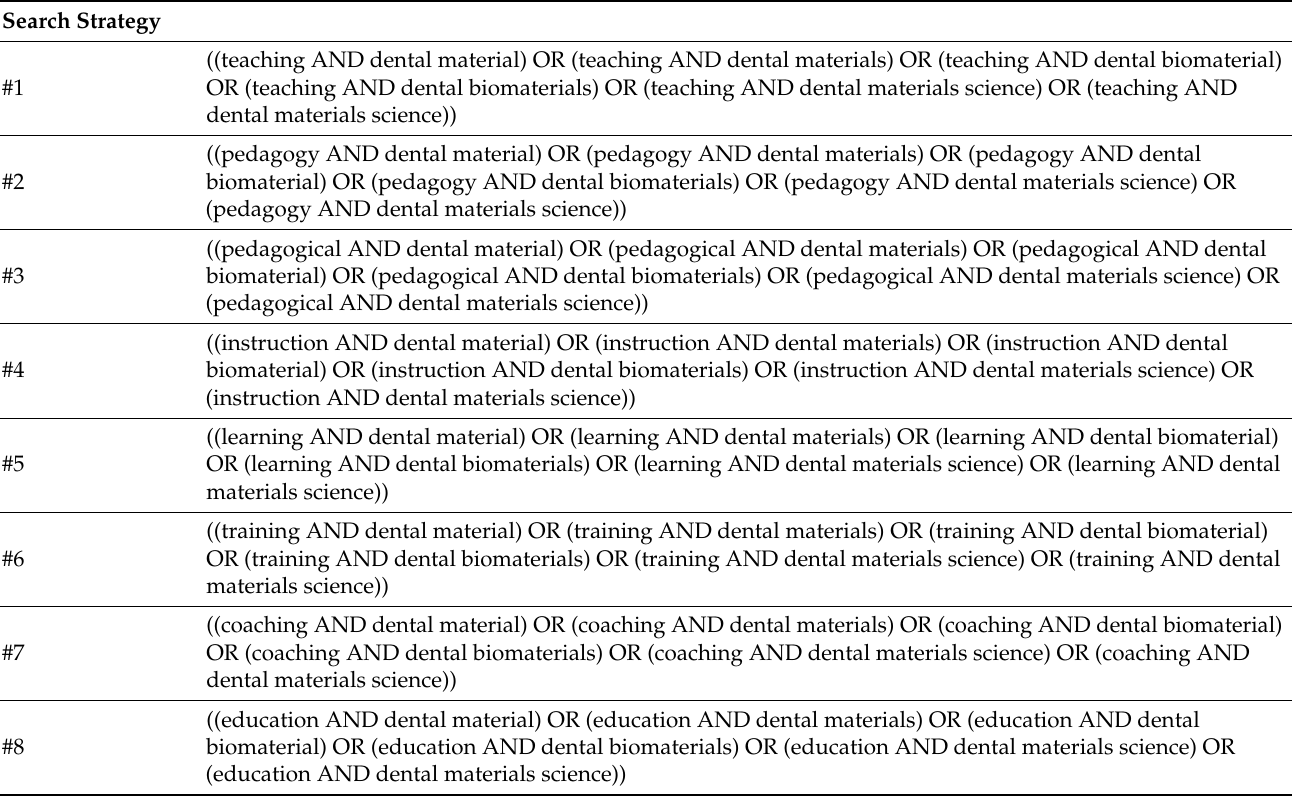
Table 1. PubMed search